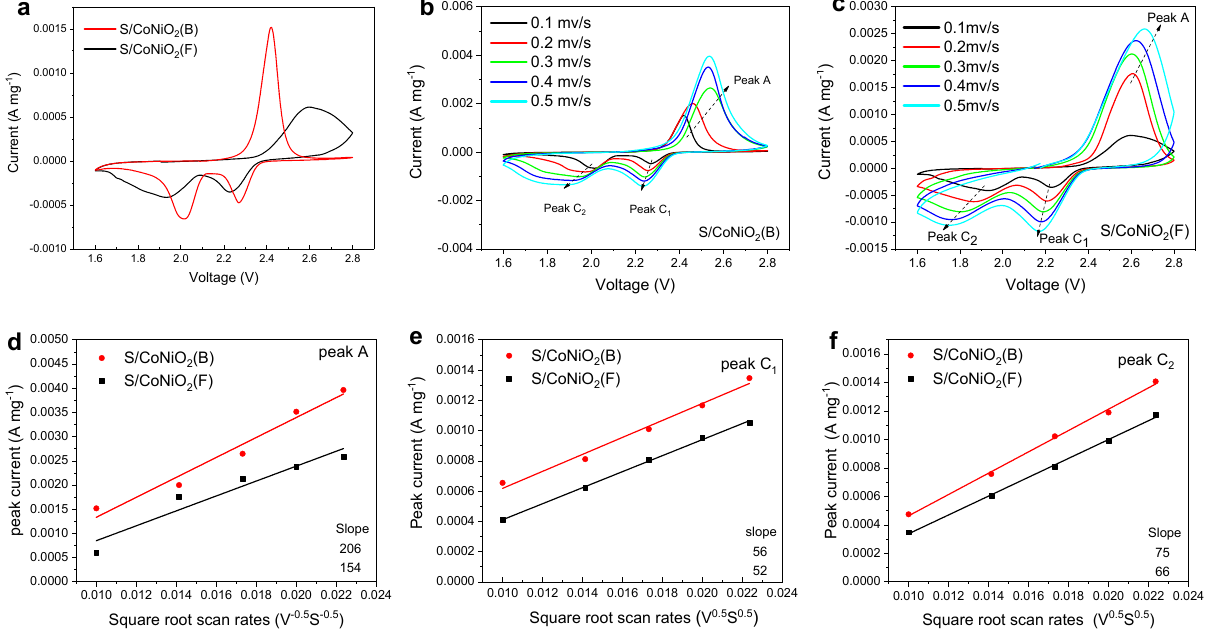
Figure 6. CV curves and Li+ diffusion coefficient fitting. ( a ) CV curves of S/CoNiO 2 (B) and S/CoNiO 2 (F) electrode at 0.1 mV s − 1 . CV curves of ( b ) S/CoNiO 2 (B) and ( c ) S/CoNiO 2 (F) electrode at 0.1–0.5 mV s − 1 . ( d – f ) The peak current of the CV curve is linearly related to the square root of the corresponding scan rate.